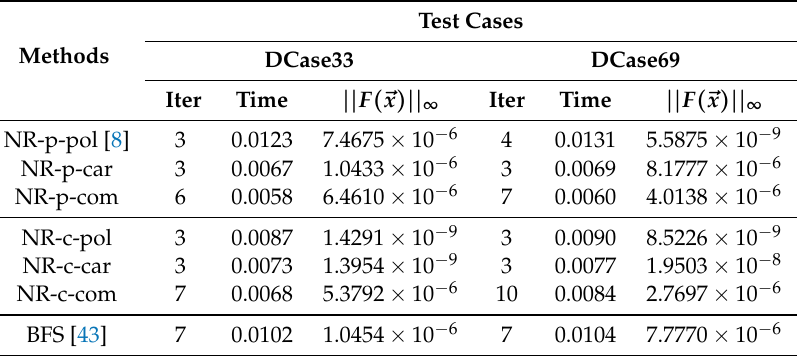
Table 3. Balanced distribution networks: DCase33 and